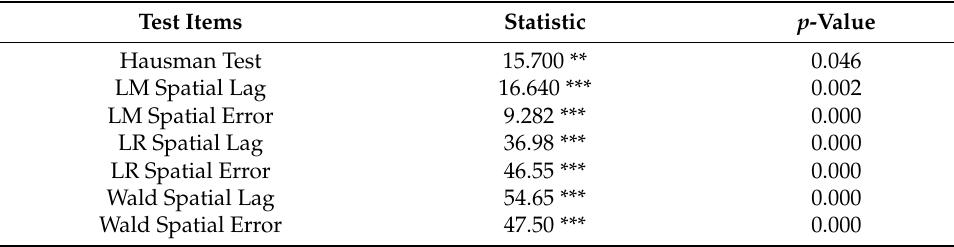
Table 4. Spatial panel model test